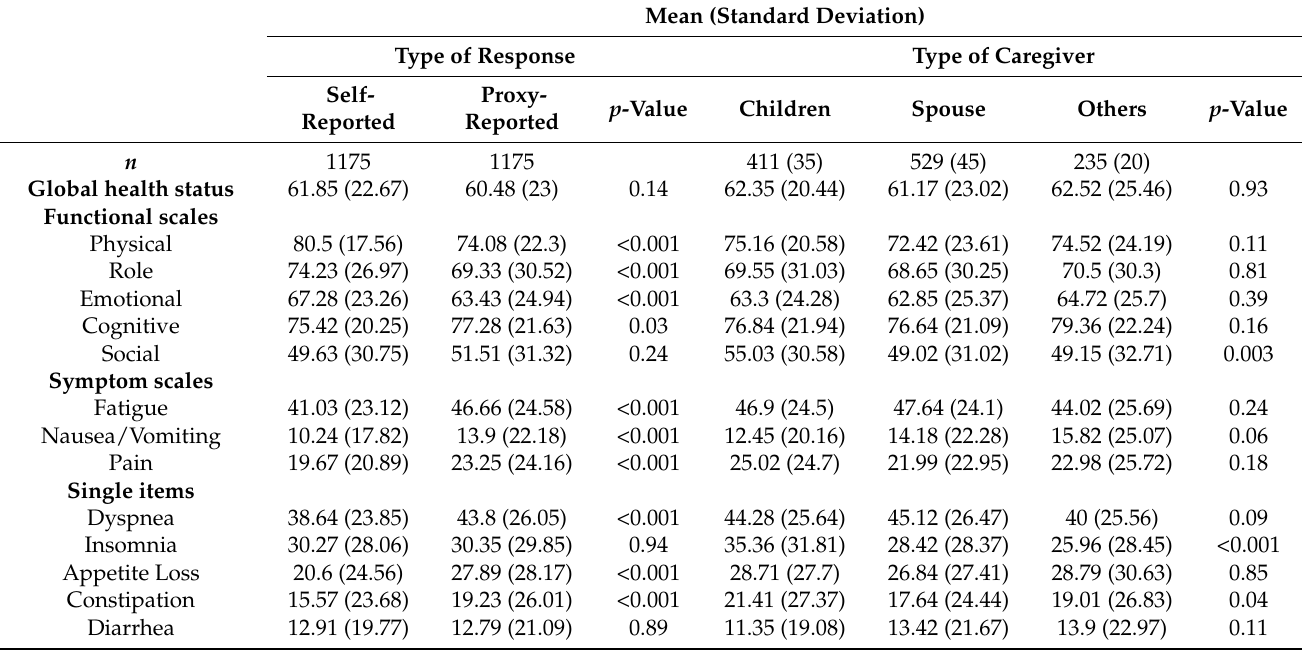
Table 2. Patients’ QoL measured by QLQ-C30 and stratified by response type. Mean (Standard